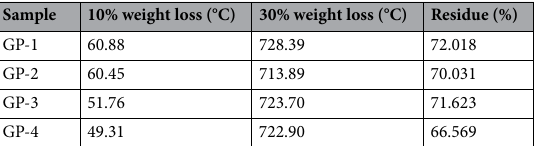
Table 2. Thermal stability of the geopolymer composites obtained from